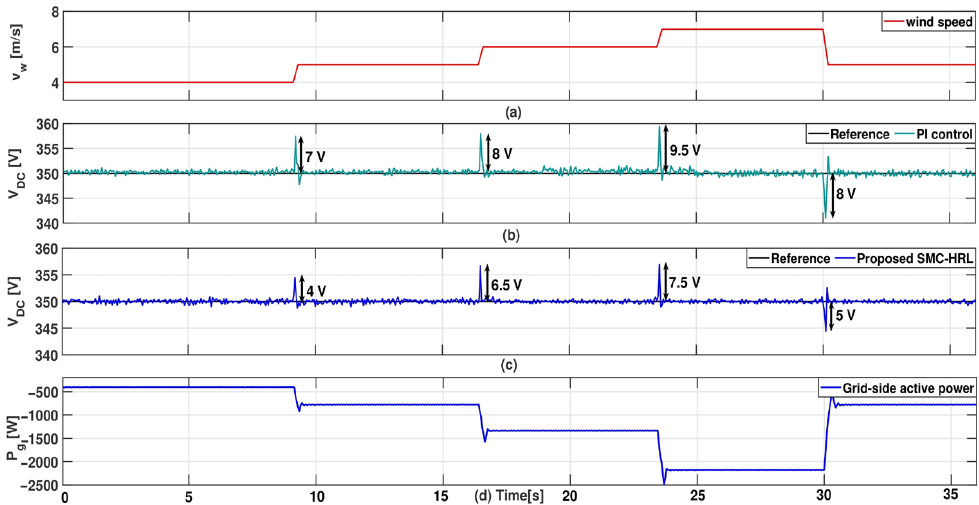
Figure 10. Experimental responses of DC-link voltage for the wind speed variation condition. ( a ) Step- change wind profile. ( b ) PI control. ( c ) Proposed SMC-HRL control. ( d ) Grid-side active power. Table 4. Proposed SMC-HRL controller performance compared with other control methods for the step-change in DC-link reference and wind speed variation based on the experimental